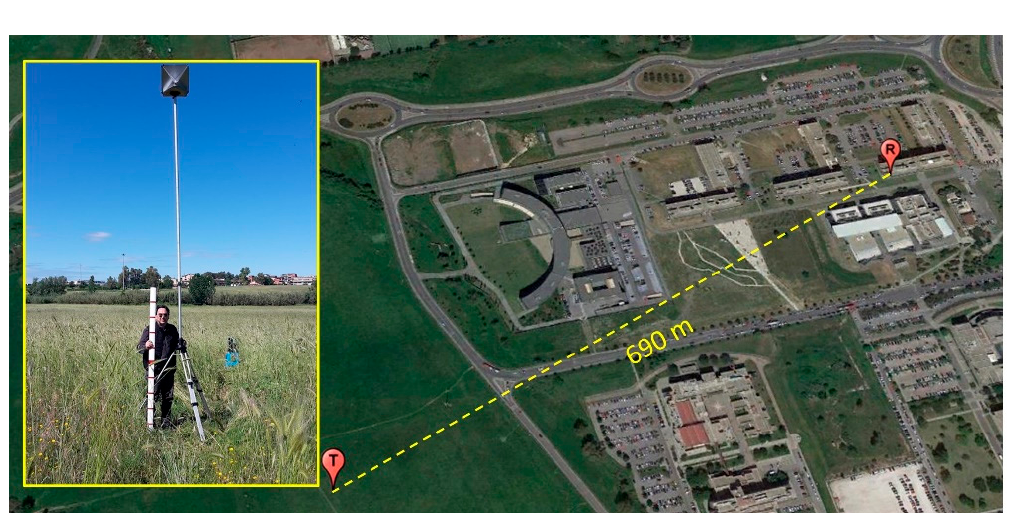
Table 2. Five positions during the trials on 16 May 2019. The last column shows the radar cross section (RCS) estimate for the medium corner reflector (CR).